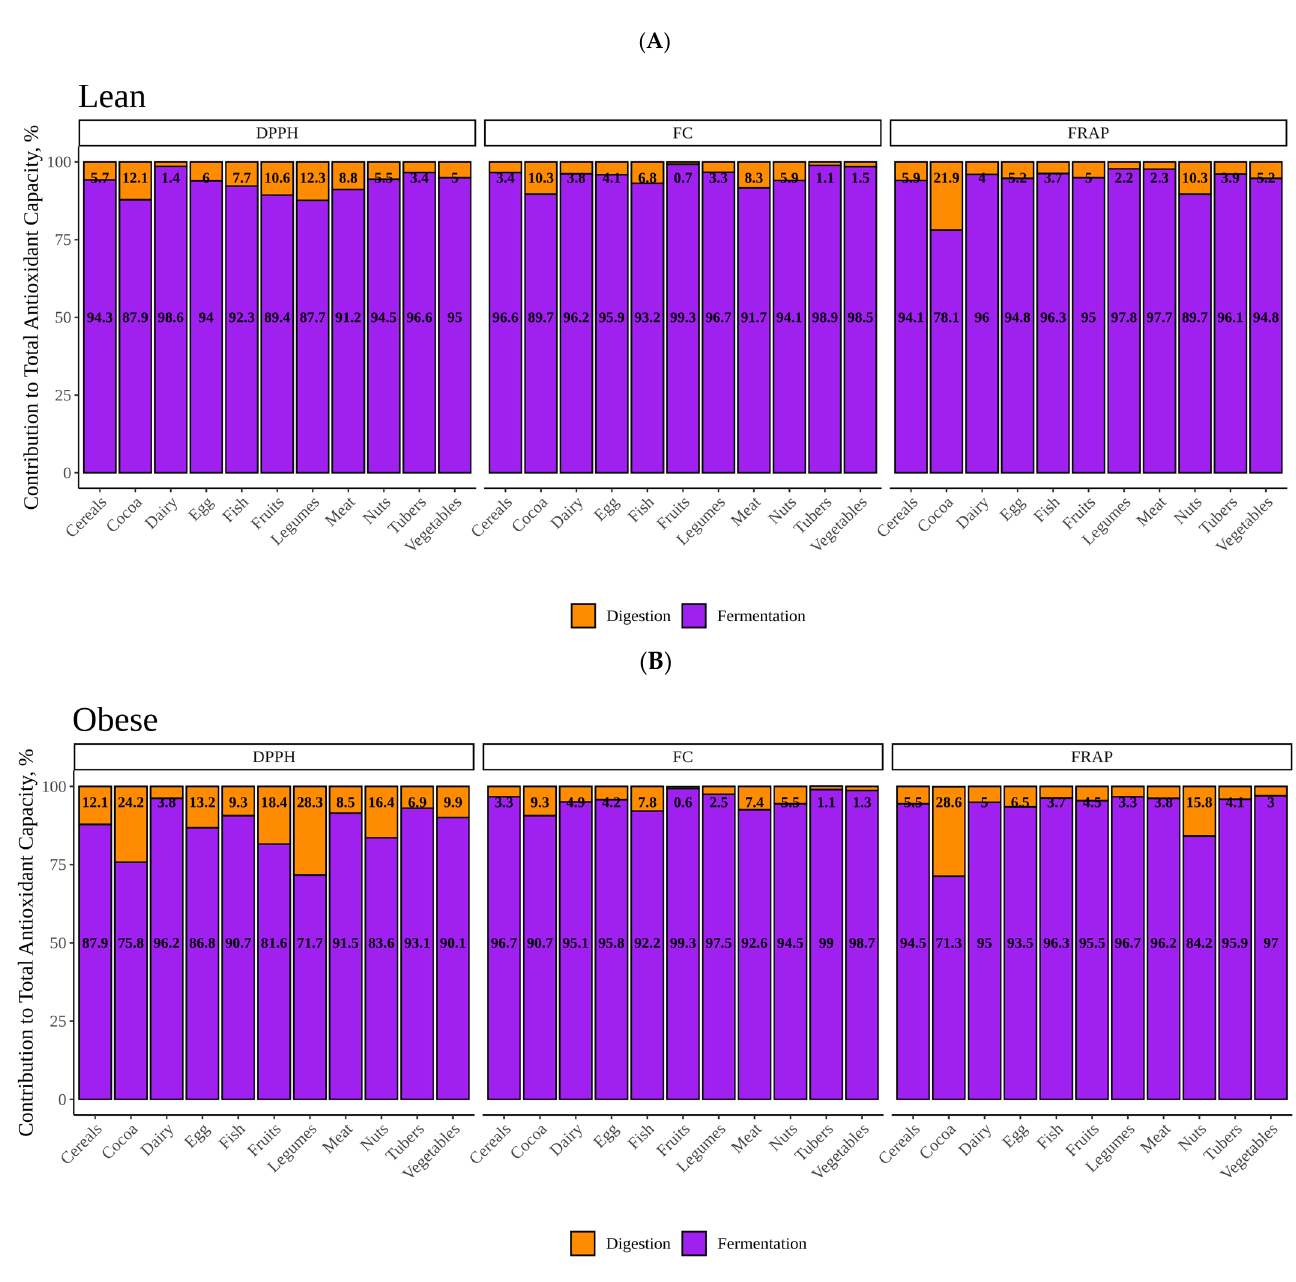
antioxidant capacity of each group. Dots represent the antioxidant capacity of each food within the group. Statistical analysis was performed via Kruskal–Wallis test. Comparisons were made using “Lean” as the reference group. Statistic labels: *— p < 0.05, **— p < 0.01, ***— p < 0.001, ns—not significant.